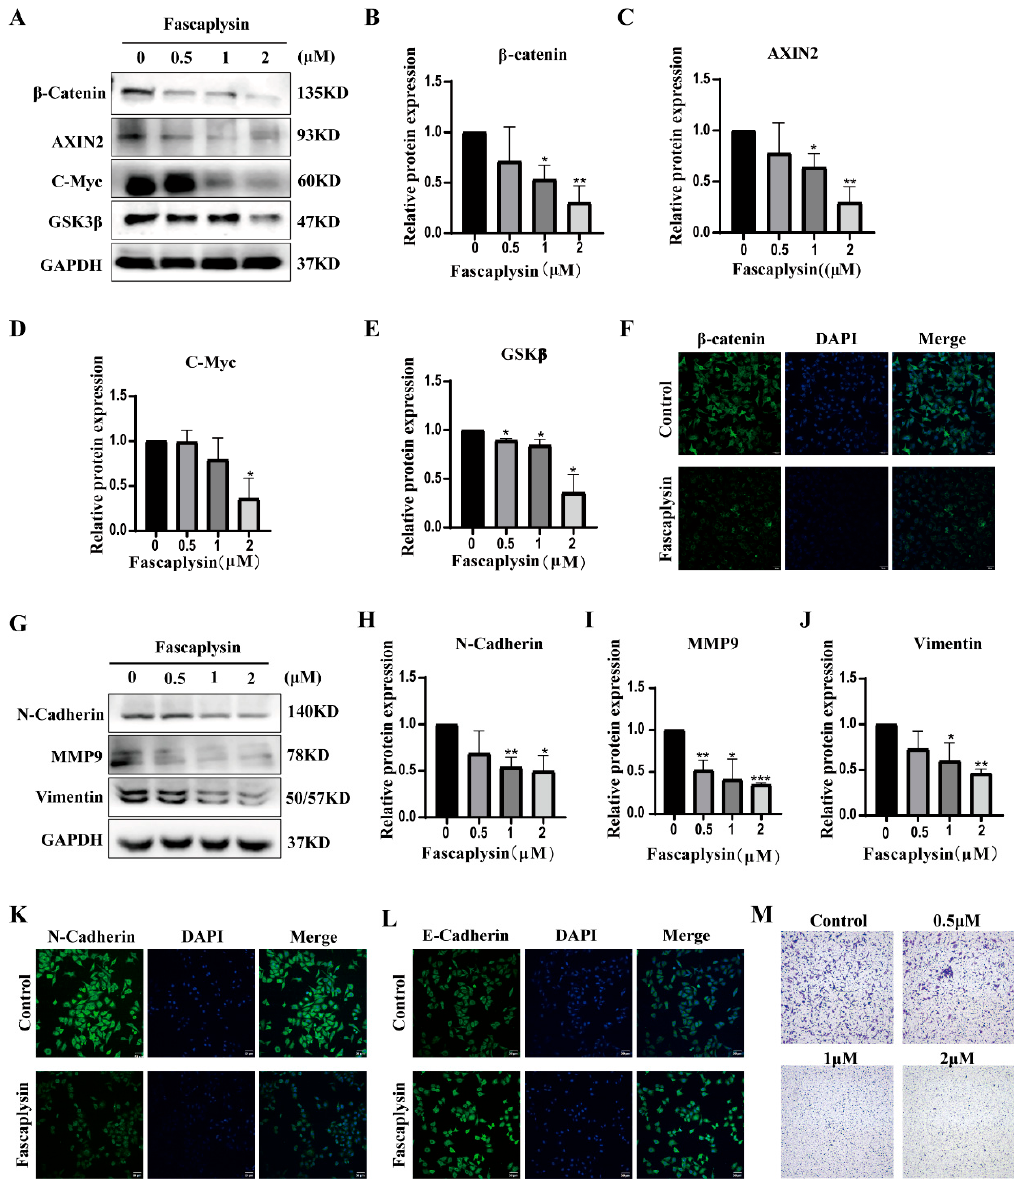
Figure 2. Fascaplysin inhibited A549 cells migration. ( A ) Wnt/ β -Catenin signaling pathway-related proteins were detected by Western blotting. ( B – E ) Gray levels of Wnt/ β -Catenin signaling pathway- related proteins were quantified using ImageJ and normalized to gray levels of GAPDH protein. ( F ) After A549 cells were treated with fascaplysin (2 μ M) for 3 h, β -catenin protein expression levels were detected using immunofluorescence. ( G – J ) Detection of EMT regulatory proteins by Western blotting. ( K , L ) Immunofluorescence analysis of the levels of N-cadherin and E-cadherin in A549 cells. ( M ) A549 cell migration assays were performed using transwell inserts and representative images were randomly photographed. Analysis results represent mean ± SD, * p < 0.05, and ** p < 0.01, *** p < 0.001.